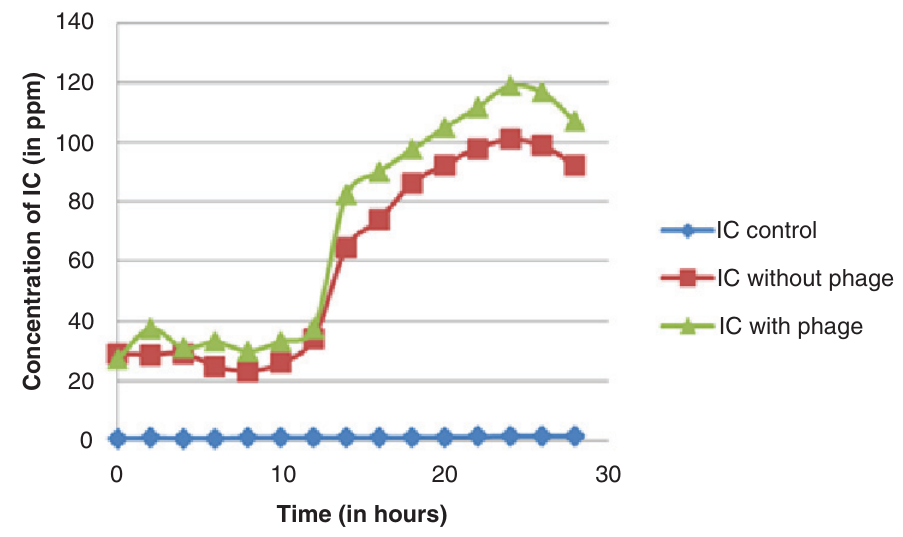
Figure 4. Variations in inorganic carbon content (in ppm) with respect to time (in hours).